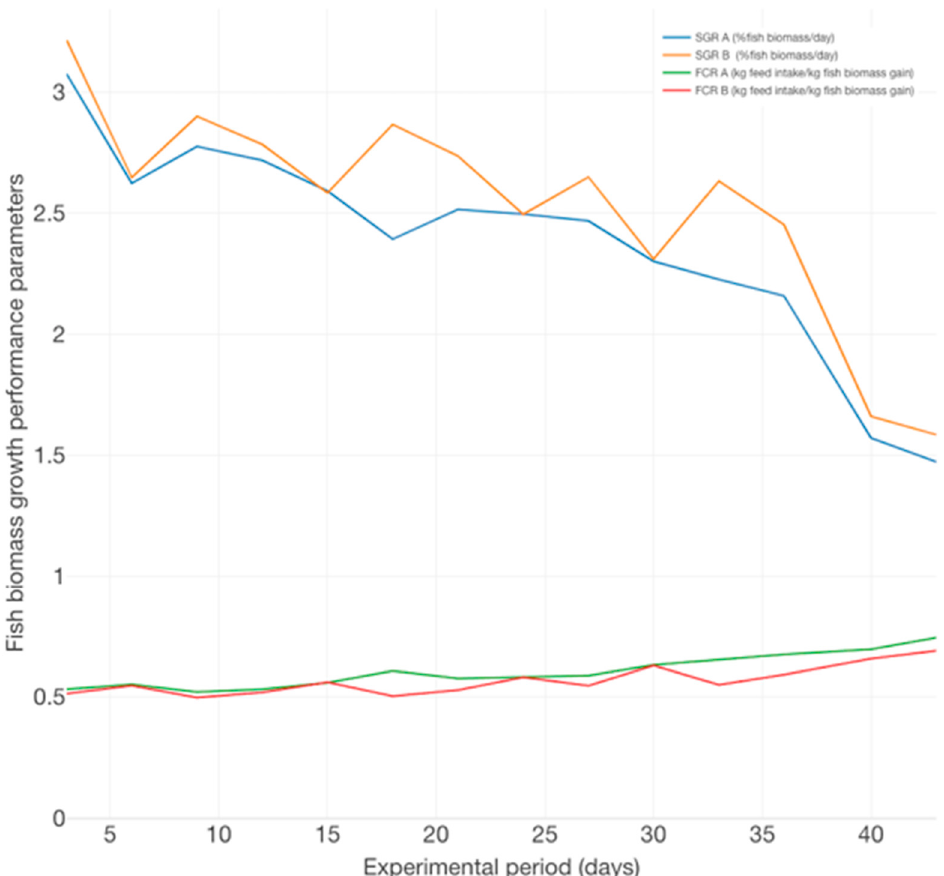
Figure 2. The trend of SGR and FCR during the experimental trial, for both A and B experimental; variants associated with different growth scenarios.